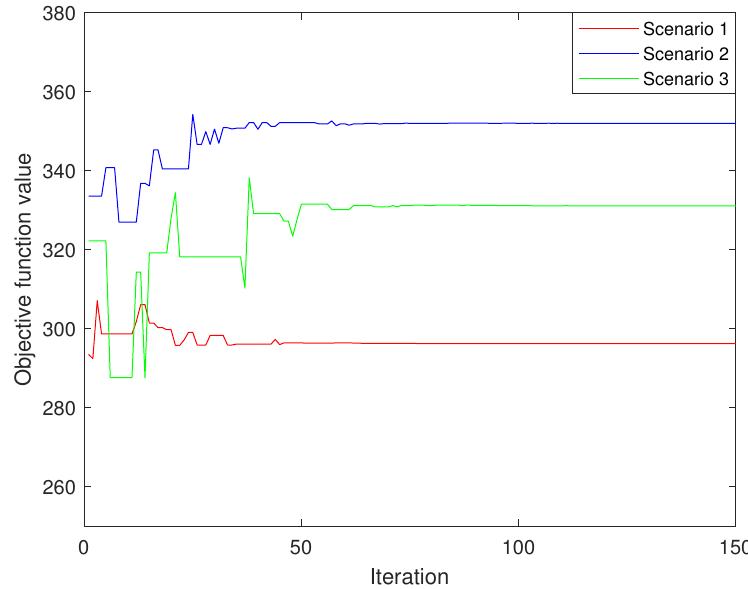
Figure 9. Convergence graph of PCBSE in three